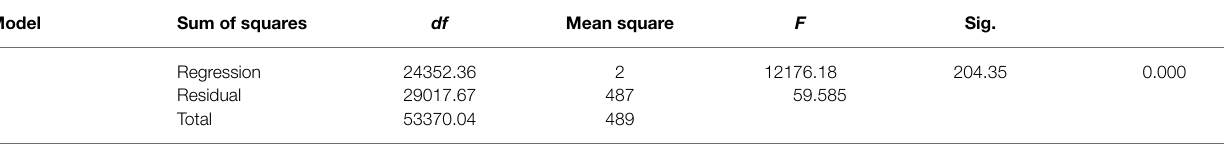
TABLE 4 | ANOVA for academic engagement, L2 enjoyment, and motivation. Model